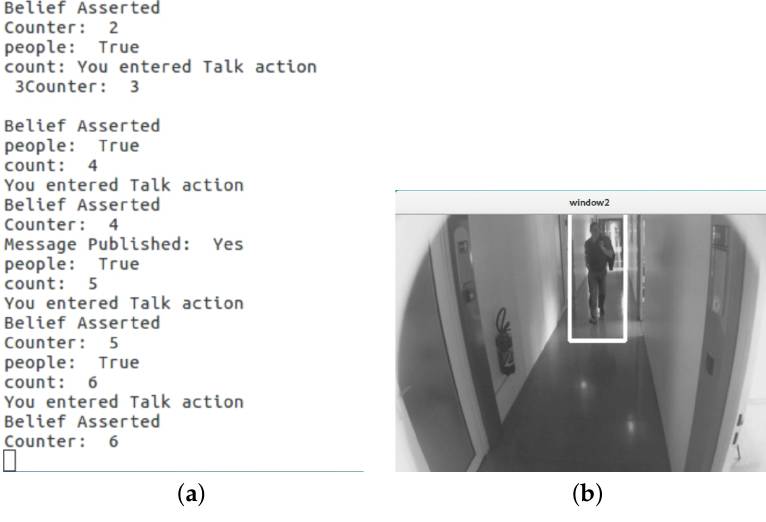
Figure 5. Case: no person detected ( a ) BDI execution and ( b ) image feed collected by eyes of Waldo.